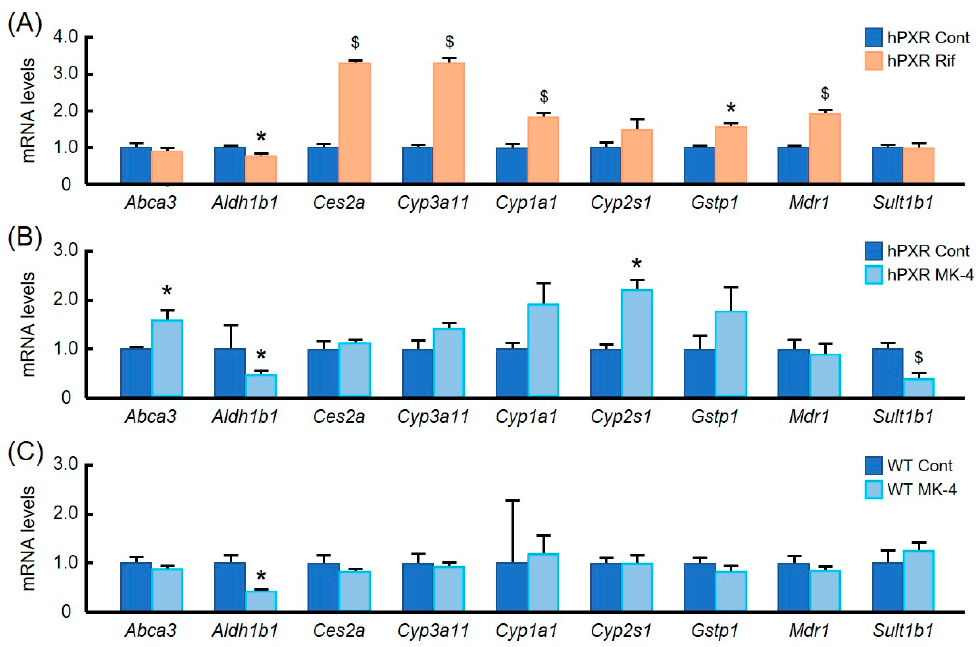
Figure 2. Effects of menaquinone-4 and rifampicin on the expression of genes encoding drug metabolizing proteins in the liver of wild-type and hPXR mice. Rifampicin (Rif; 50 mg/kg of body weight) was given by oral gavage to hPXR female mice ( A ). Menaquinone-4 (MK-4; 100 mg/kg of body weight) was given by oral gavage to hPXR ( B ) and wild-type ( C ) female mice. After 6 h, mRNA levels of genes that encode drug metabolizing proteins were measured by quantitative RT-PCR. The relative mRNA levels were normalized to the amount of eukaryotic translation elongation factor 1 α 1 mRNA. Data are expressed as the mean ± SEM, n = 4–5. $ p < 0.01, * p < 0.05, compared to control groups.